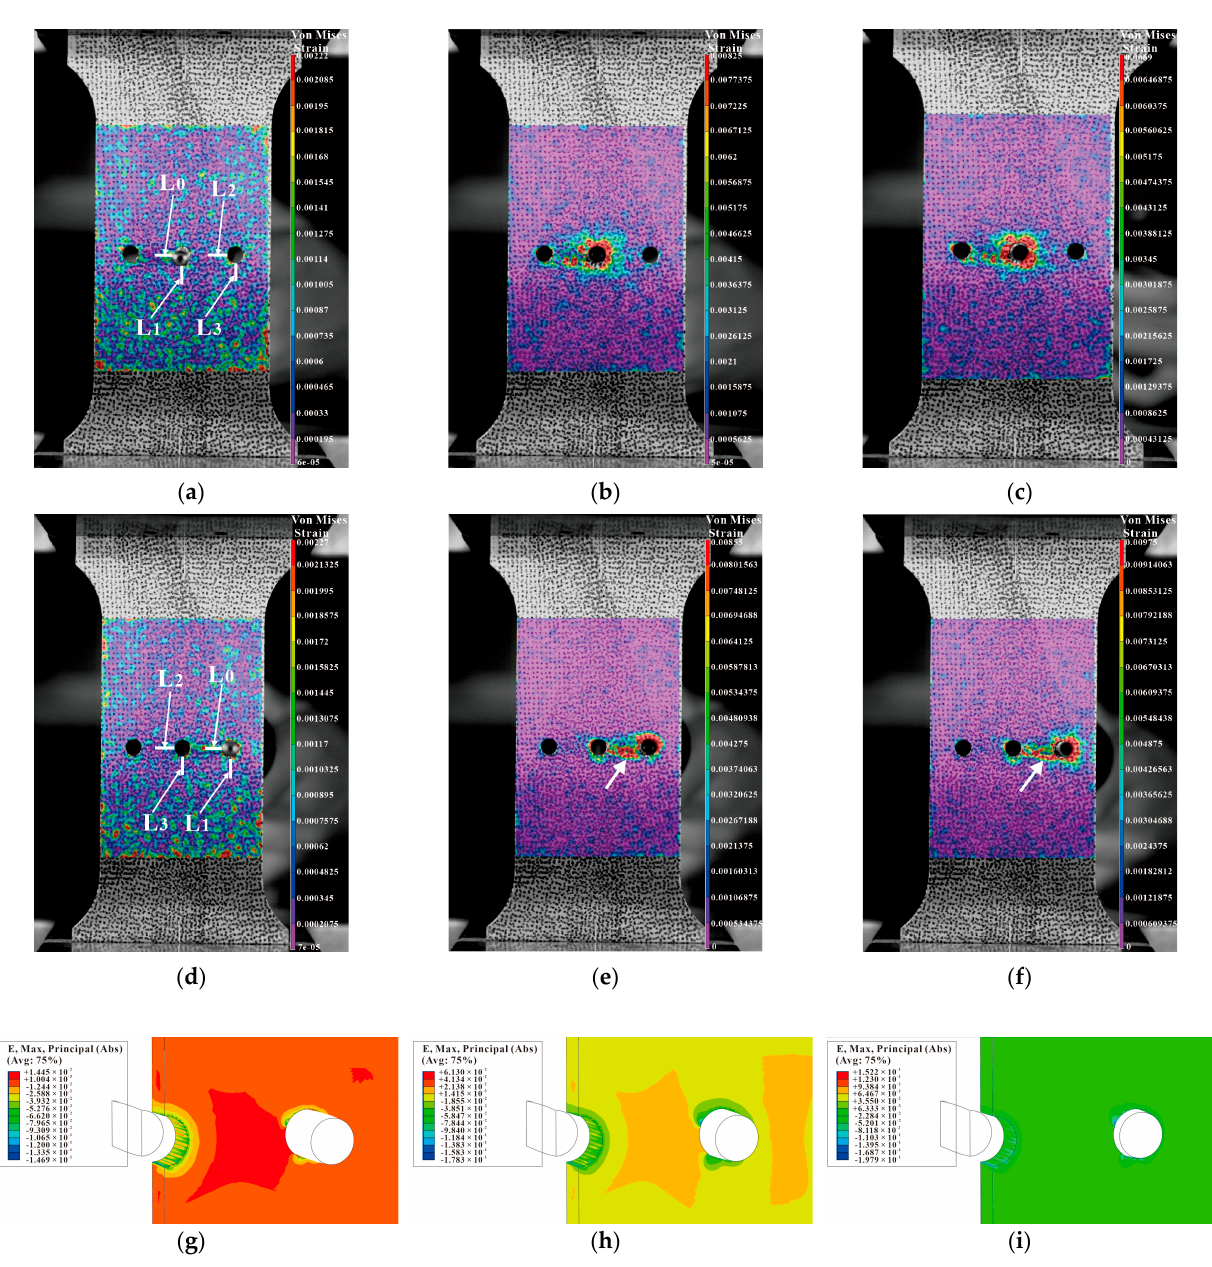
Figure 24. Comparison between DIC strain detection and FEM-predicted strain of three-hole speci- men with three times the hole diameter as hole spacing (first middle hole is squeezed, then left hole, and finally right hole): ( a – c ) strain distributions before, during, and after SSCE of the middle hole; ( d – f ) strain distributions before, during, and after SSCE of the right hole; ( g – i ) the right-hole SSCE strain distribution of FEM.